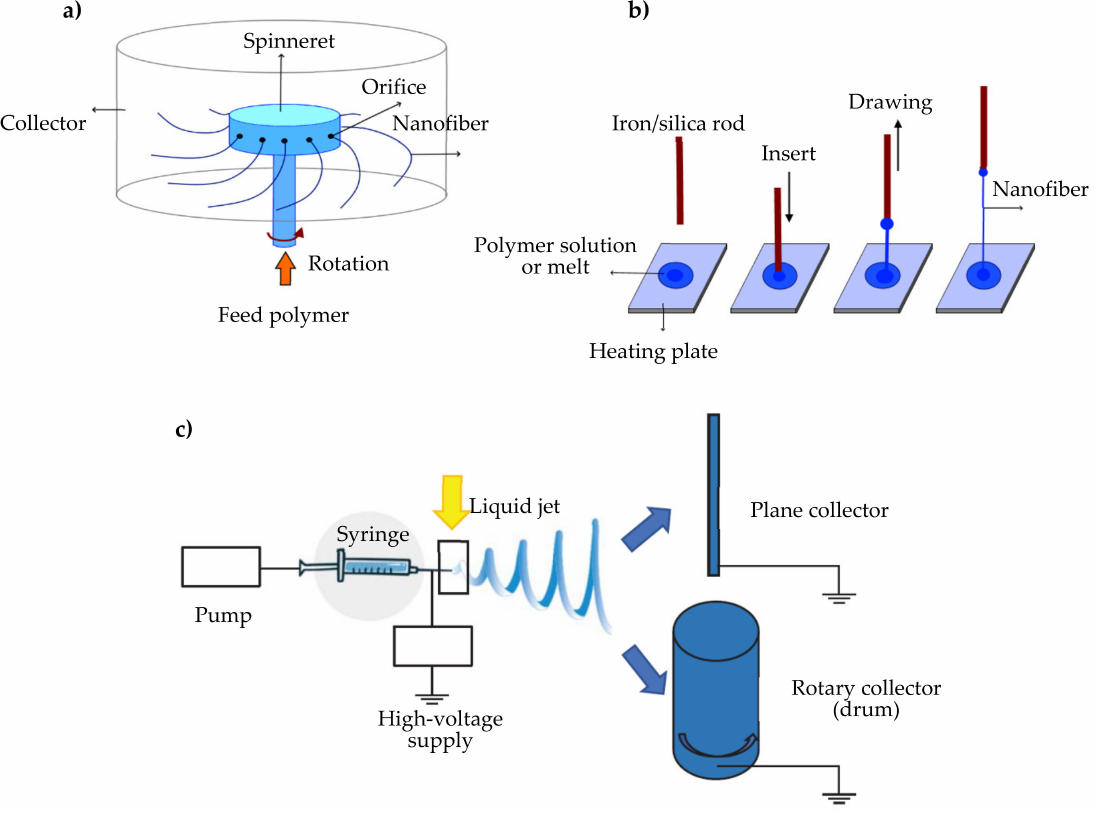
Figure 1. ( a ) Centrifugal spinning, ( b ) direct drawing technique and ( c ) electrospinning apparatus. Modified from [61] with